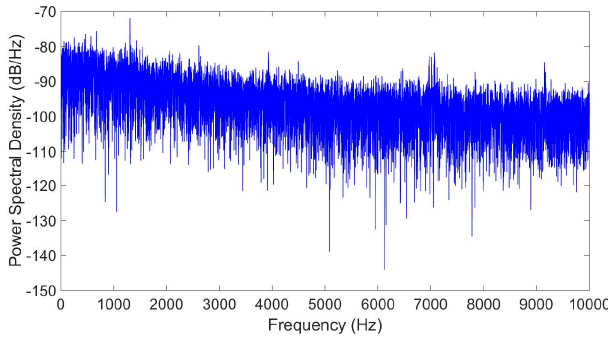
Figure 6. Fast Fourier Transform of the sampled data.